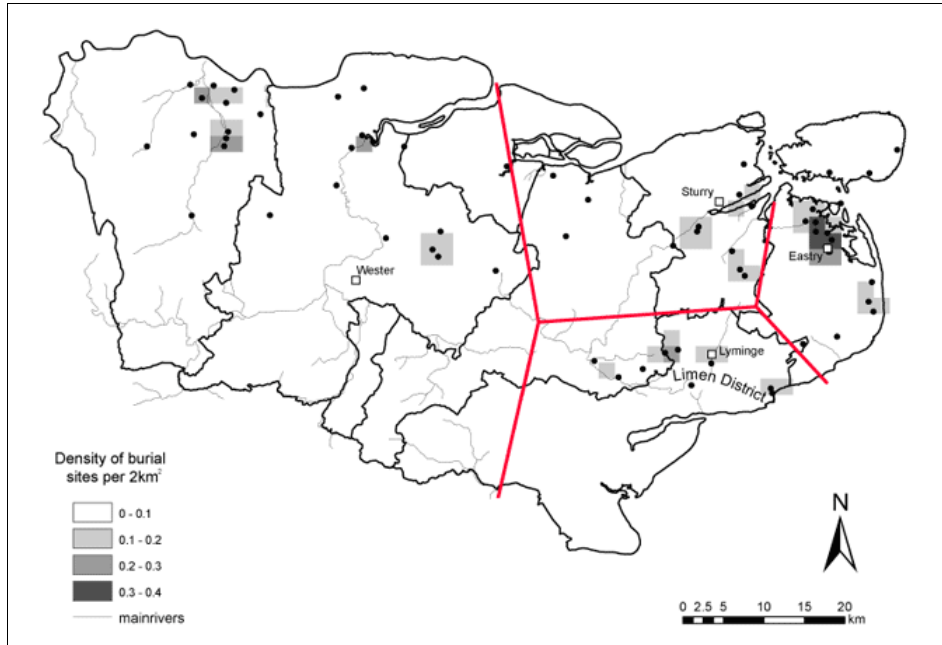
Fig. 7: The lathes of Kent, in 1086, with a density plot of early Anglo-Saxon burial sites in Kent and Thiessen polygons calculated around the g ē settlements (lathe capitals) of eastern